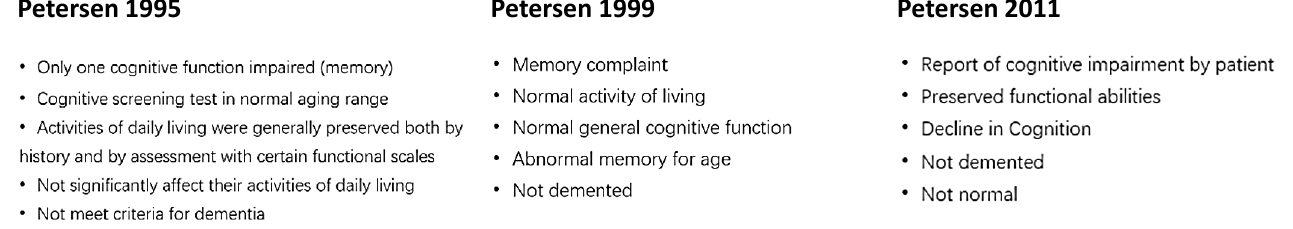
Figure 2. Evolution of diagnostic criteria for MCI from 1995 to 2011 [40 – 42].